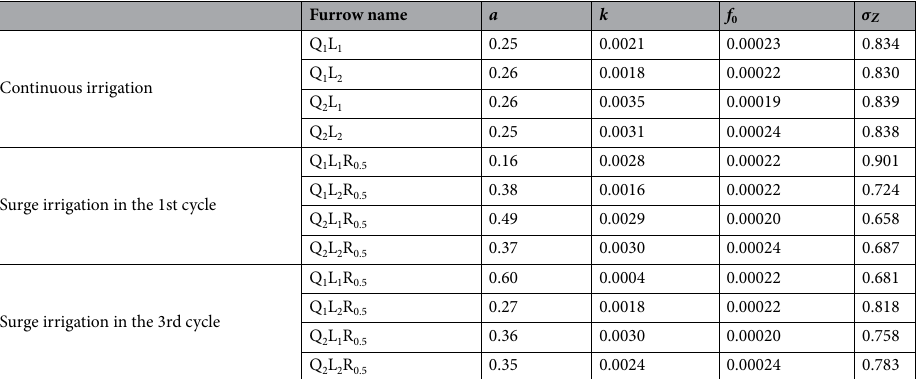
Table 3. Field-measured Kostiakov-Lewis infiltration parameters and the subsurface profile shape factor of the continuous and surge irrigations based on the two-point method. Q: stream size; L: furrow length; R 0.5 : surge irrigation with cycle ratio of 0.5. k and a : empirical coefficients ( a :dimensionless, k : m 3 min −α m −1 ); f 0 basic infiltration rate (m 3 m −1 min −1 ); σ z : subsurface profile shape